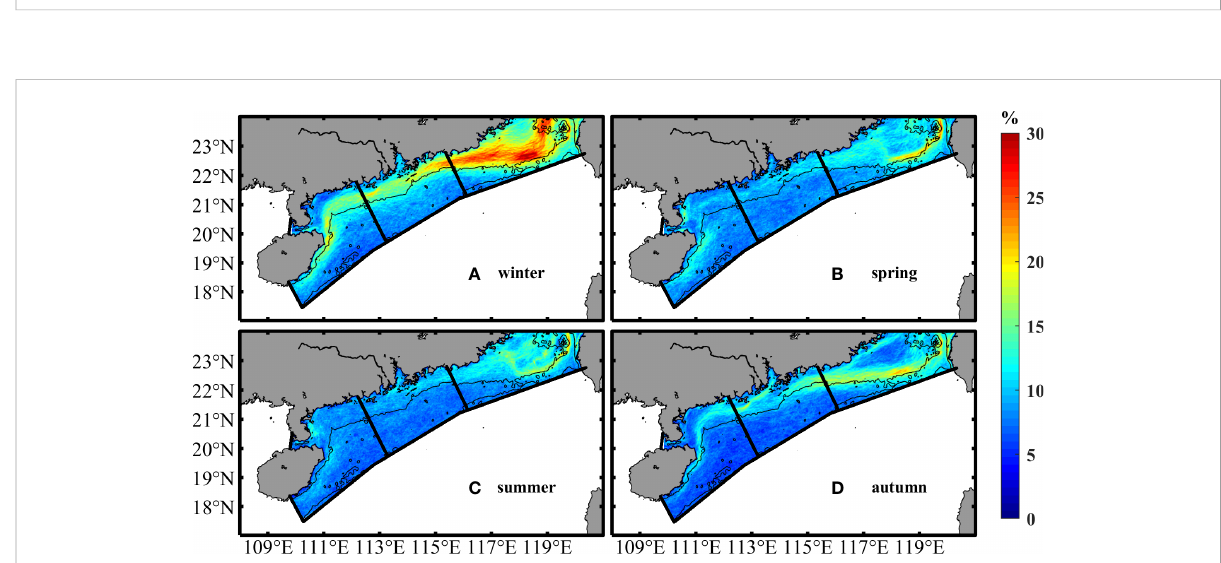
FIGURE 5 Seasonal frontal probability averaged over 2002-2021 for (A) winter (January-March), (B) spring (April-June), (C) summer (July-September), and (D) autumn (October-December).The black lines are the 50-m and 200-m isobaths.